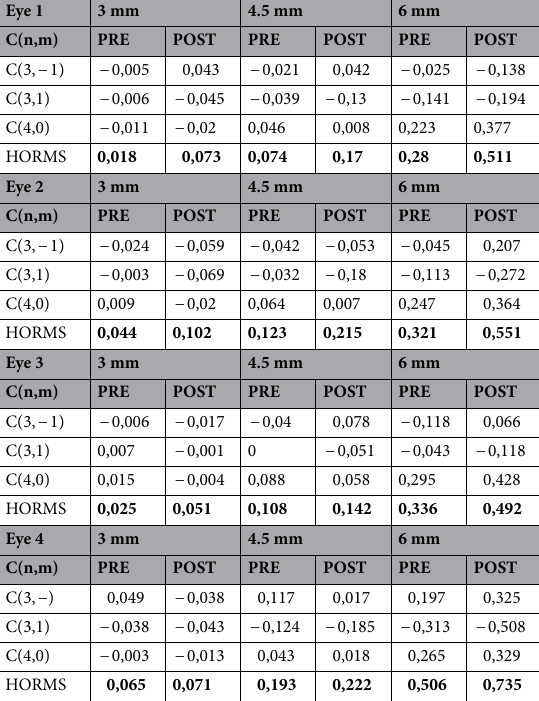
Table 5. Pre-and Post-LASIK surgery Spherical and coma Zernike coefficients of the total cornea measured with the PENTACAM for the four eyes. High Order RMS aberrations (HORMS) were calculated onsidering the Zernike coefficients from the third to eighth